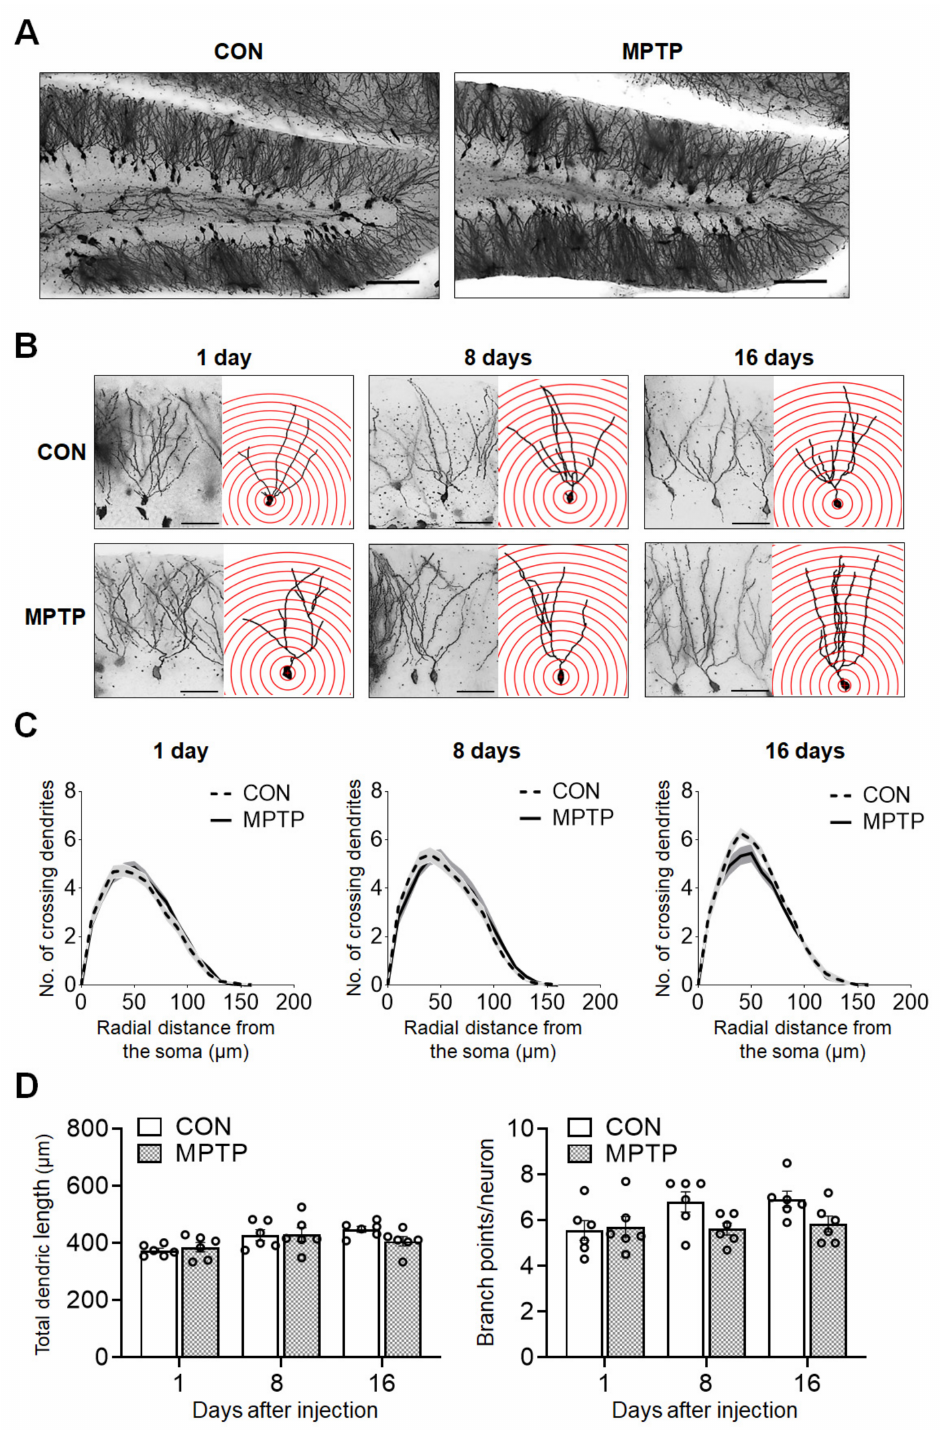
Figure 4. Acute MPTP treatment did not change dendritic complexity in dentate gyrus (DG) granular neurons. Golgi staining of brains from the control (CON) and MPTP groups revealed comparable dendritic complexity in the DG region. ( A ) Representative images of the DG subregion of CON and MPTP-treated group at lower magnification. ( B ) Representative images of DG granular neurons from the CON and MPTP-treated groups at 1, 8, and 16 days after injection at higher magnification. ( C ) Line graphs show the mean number of dendrite intersections per 10 µ m radial unit distance from the soma. ( D ) Bar graphs display the total dendritic length (left panel) and dendritic branch point count (right panel). Data are expressed as the mean ± standard error ( n = 6 mice/group). The scale bars in A and B represent 100 µ m and 25 µ m,